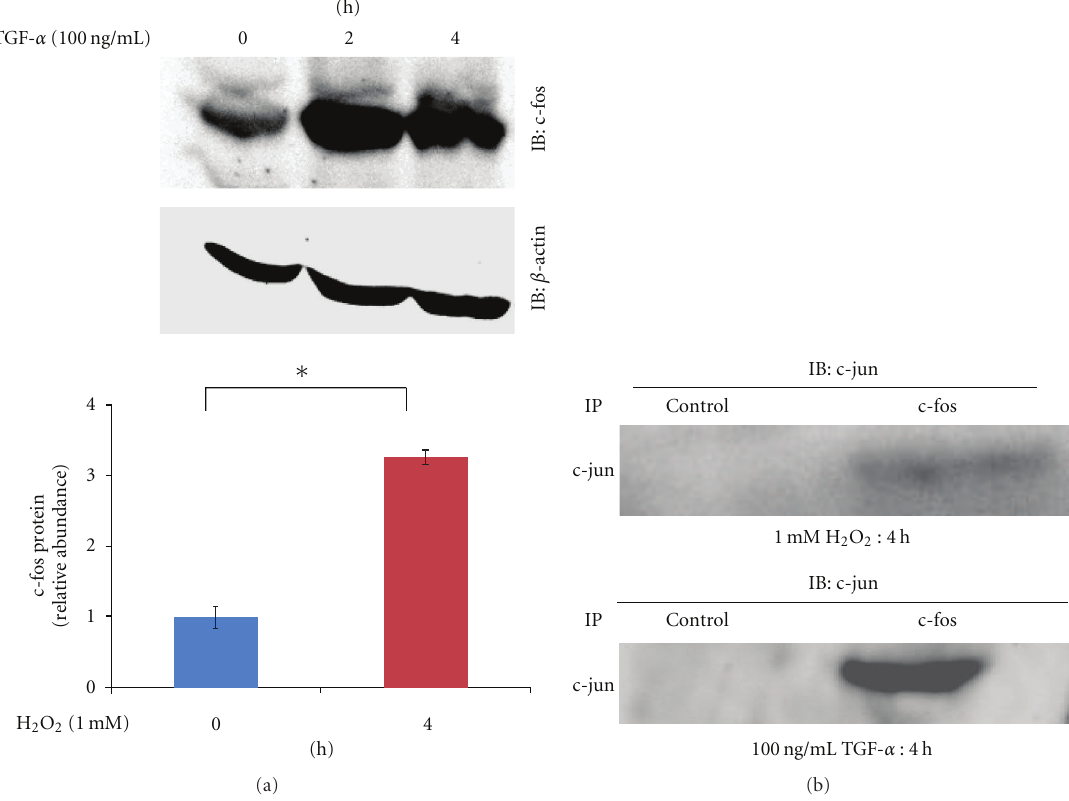
Figure 2: (a) c-fos upregulation in SiHa cells after TGF- α (100ng/mL) treatment. Cells were harvested at the indicated time points and used for Western blotting analysis. Representative blots are shown and include β -actin as a loading control, along with the results of densitometric analysis (0h, 4 h; normalized to β -actin). ∗ P < 0 . 01, n = 3. (b) IP of c-fos was performed using whole-cell extracts. Coprecipitated proteins were detected by Western blotting analysis using antibodies specific to